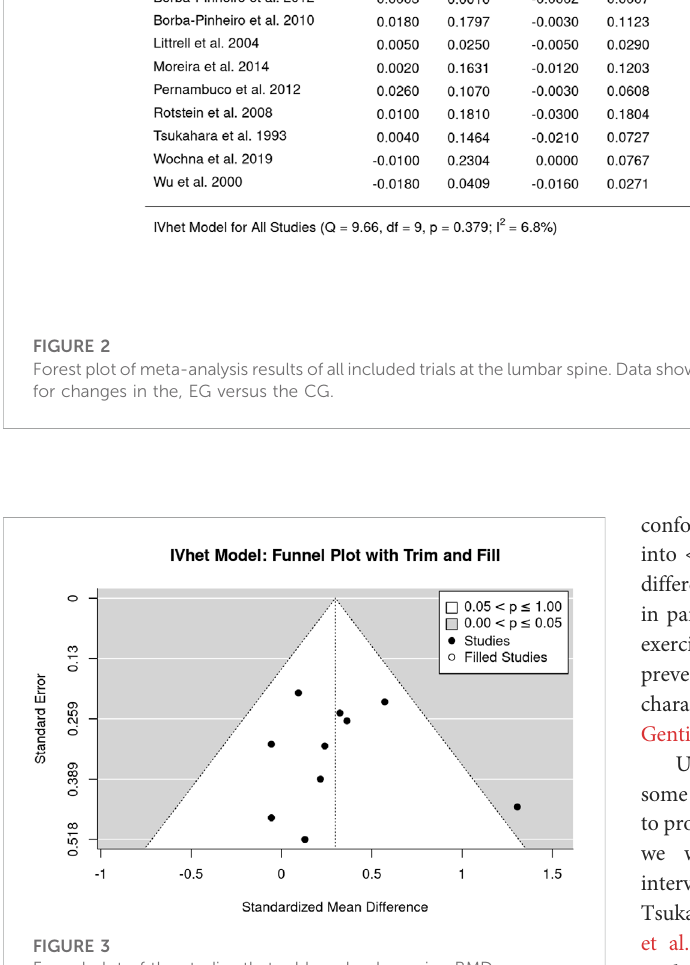
Funnel plot of the studies that address lumbar spine